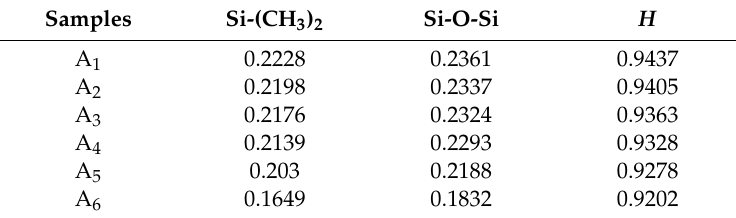
Table 5. The results for H of composite insulators.